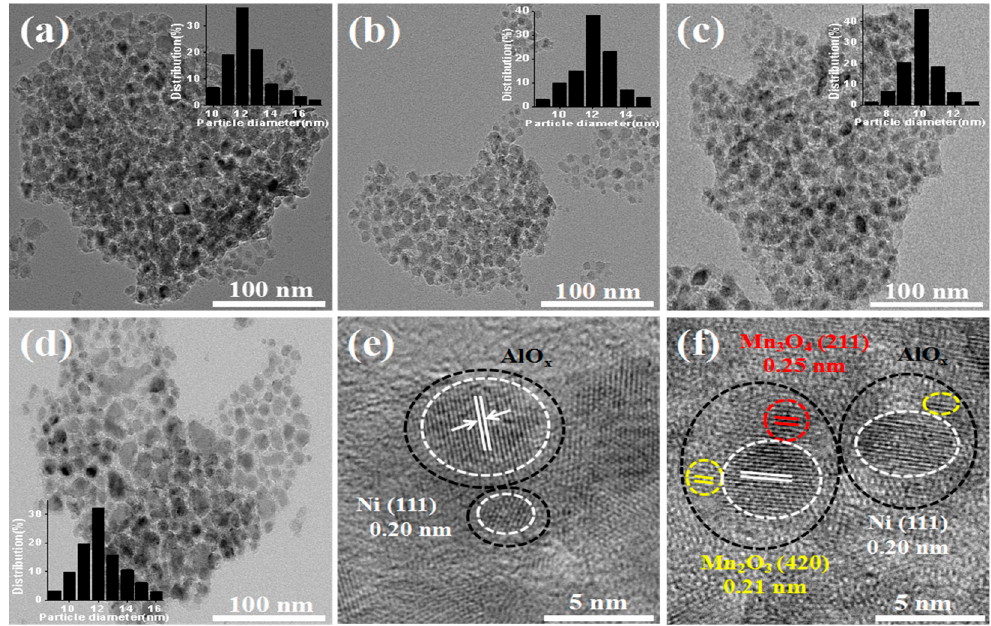
Figure 5. TEM pictures of the catalysts: ( a–f ) NiAl-C, NiMn 0.5 Al10-C, NiMn 1 Al 10 -C, NiMn 2 Al 10 -C, NiAl-C and NiMn 1 Al 10 -C. The insets show the size distribution of Ni nanoparticles.